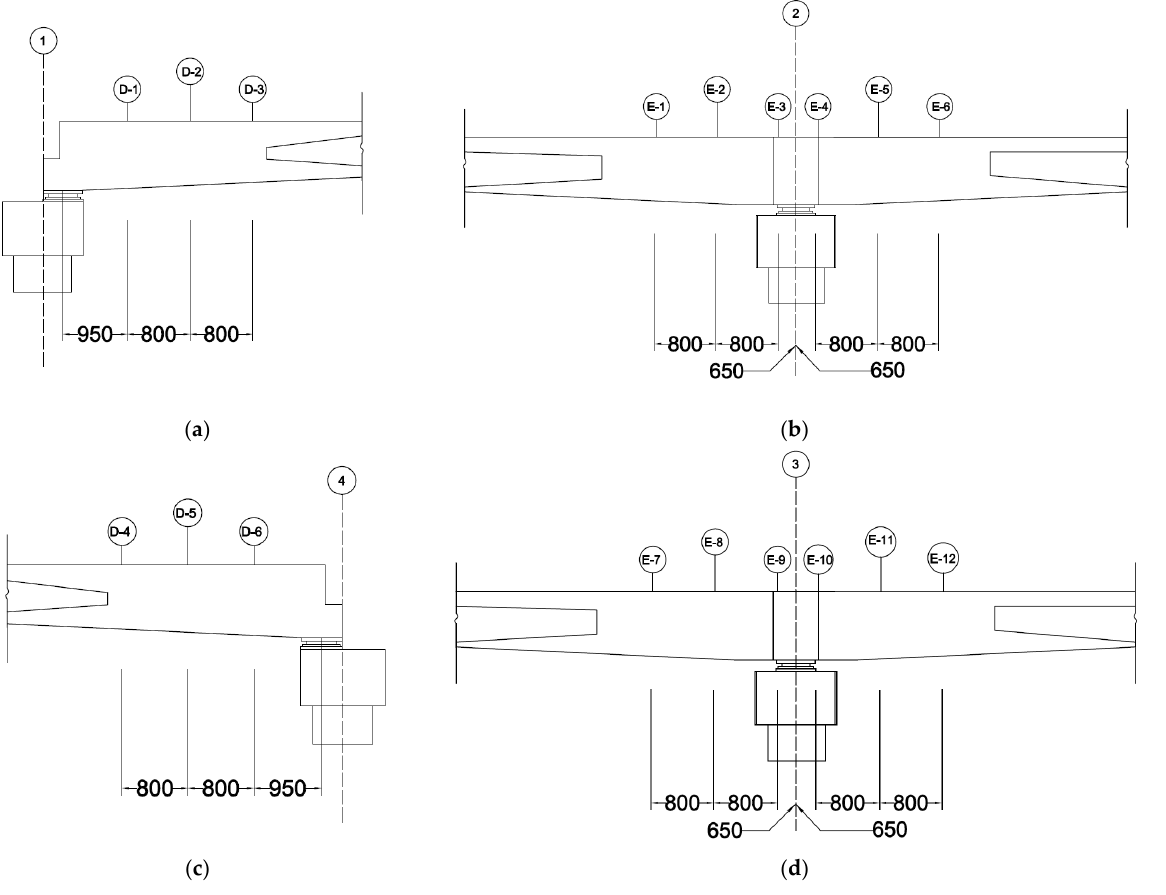
Figure 10. Details of end sections at locations ( a ) A-1, ( b ) A-2, ( c ) A-3 and ( d ) A-4 (units: mm).